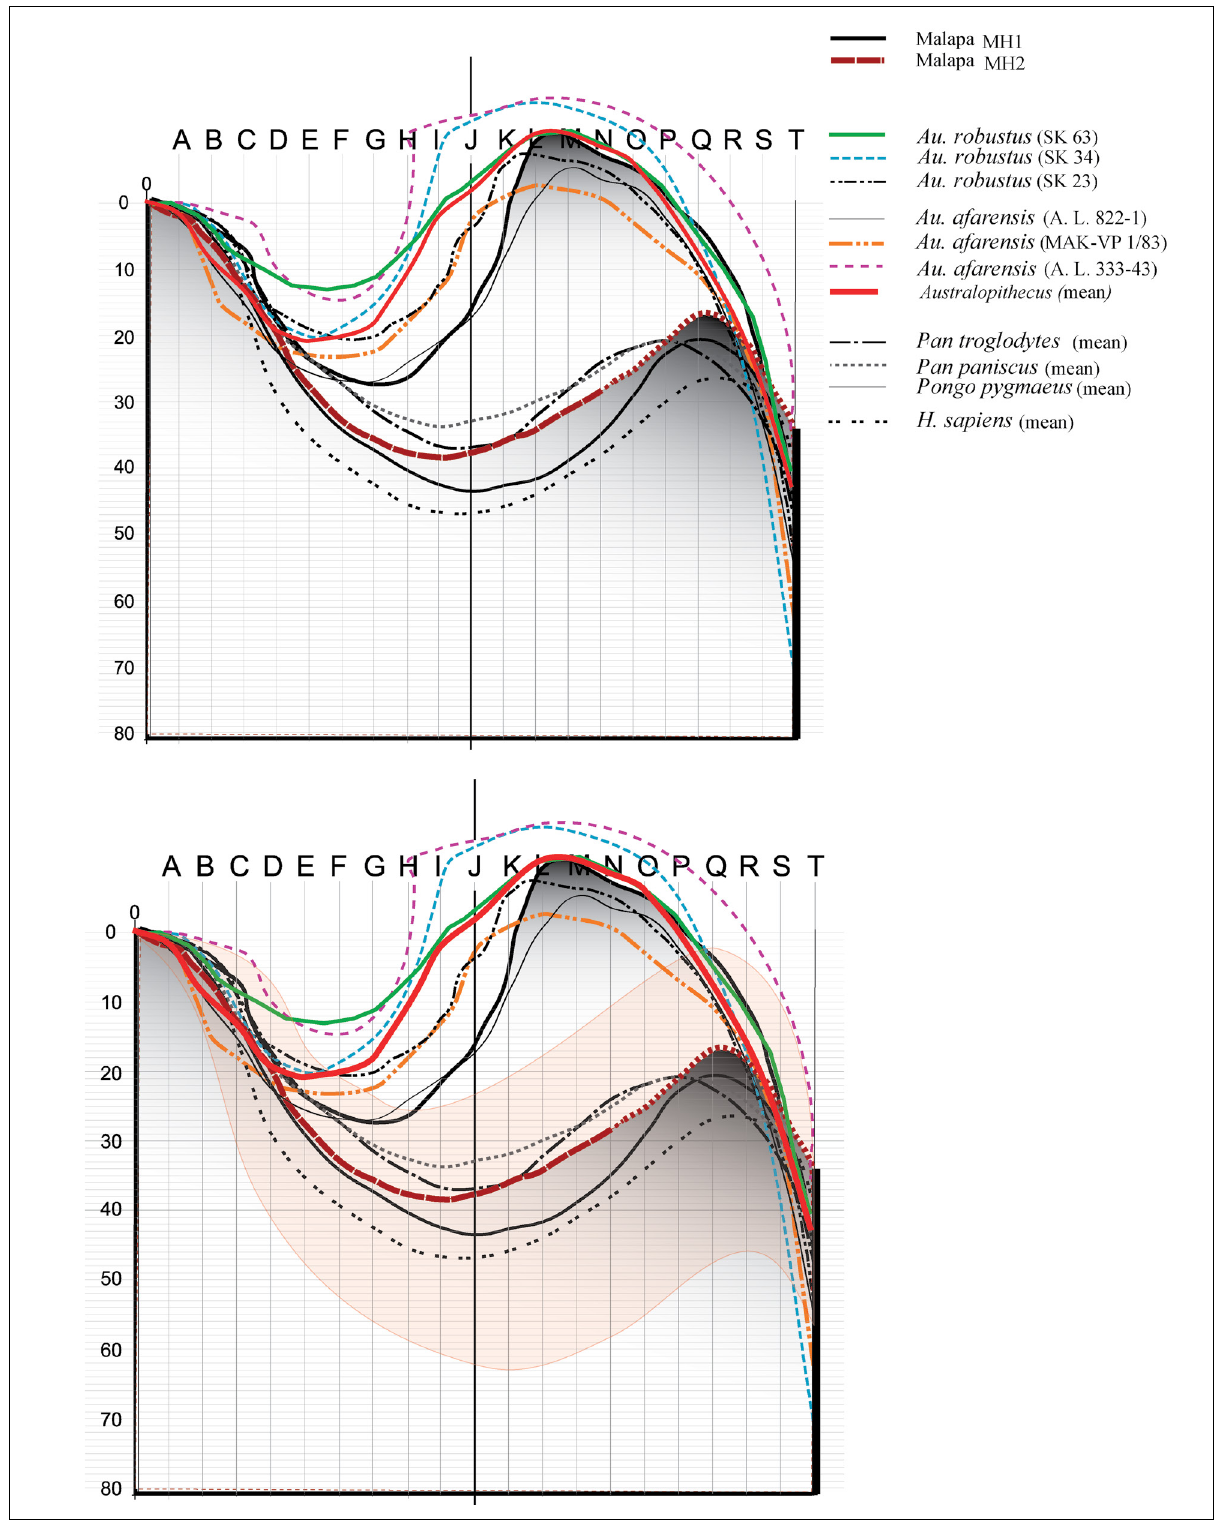
Figure 6: Ramal outlines of fossil specimens and mean ramal outlines of extant hominoid groups, stretched proportionally to fit the distance zero to T. The outlines form two distinct assemblages. Upper graph: the grey-shaded area in the upper portion of the graph represents the MH1 ramus. The lower grey-shaded area represents the MH2 ramus, delineated by the MH2 outline itself (thick, dashed maroon line). The vertical line J represents a variable that is alone sufficient to distinguish between the Australopithecus and generalised assemblages. Note that the variable J does not intersect the dotted maroon line, which represents the reconstructed coronoid tip in MH2; i.e. the reconstruction has no influence on the results. Lower graph: this graph is the same as the upper one, with the addition of the range of variation in the Homo sapiens sample (light-red shaded area). Note that the means of the extant hominoid sample fall within the range of H. sapiens